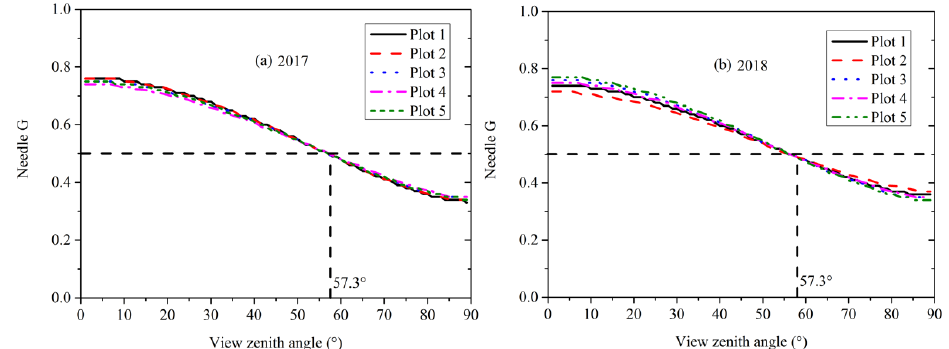
Figure 8. Whole-canopy needle projection function against viewed zenith angles in the five plots in 2017 ( a ) and 2018 ( b ).